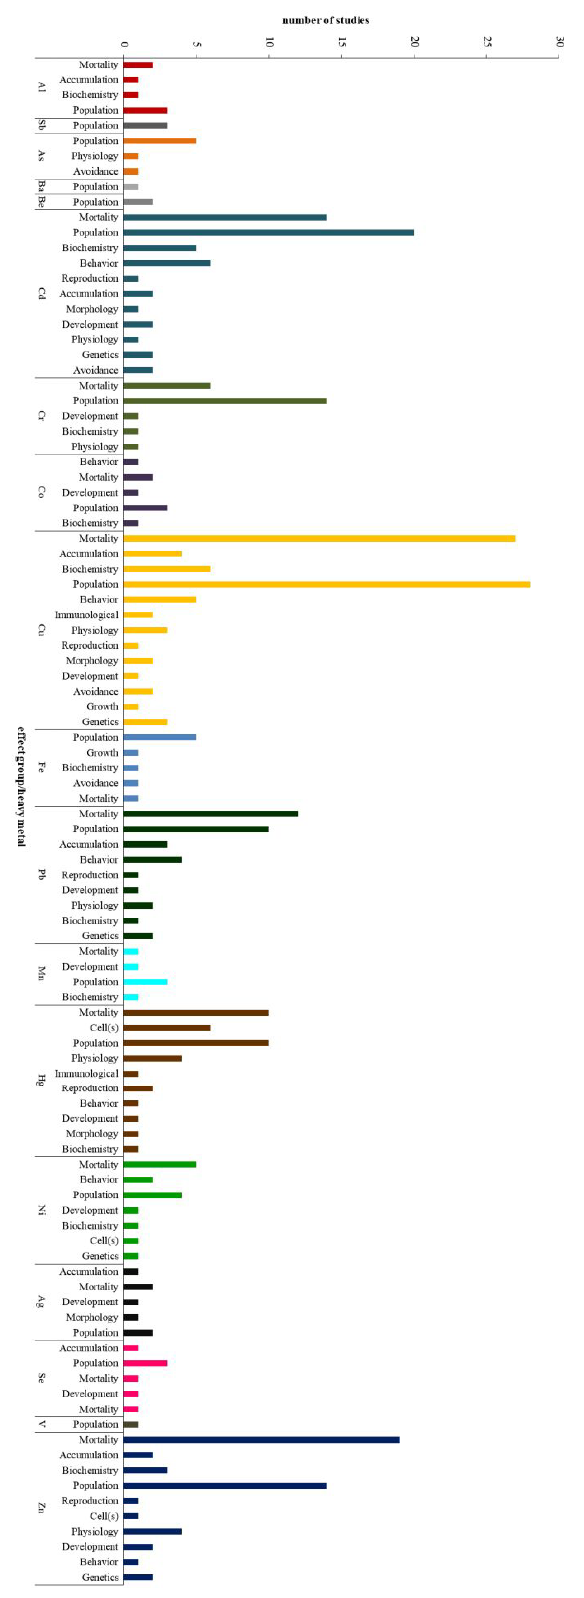
Figure 3. Number of studies with heavy metals and their respective approaches according to the Ecotox knowledgebase database (USEPA, 2019) (survey conducted on 05/28/2019);